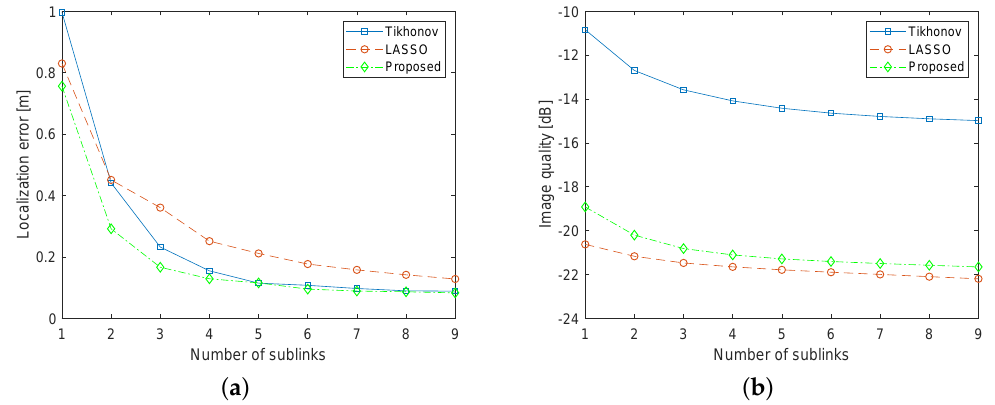
Figure 6. Impact of the number of sublinks on ( a ) localization accuracy; and ( b ) image